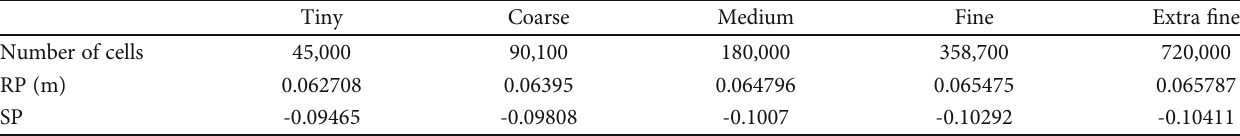
Table 5: Grid sensitivity test (24-deg compression ramp).